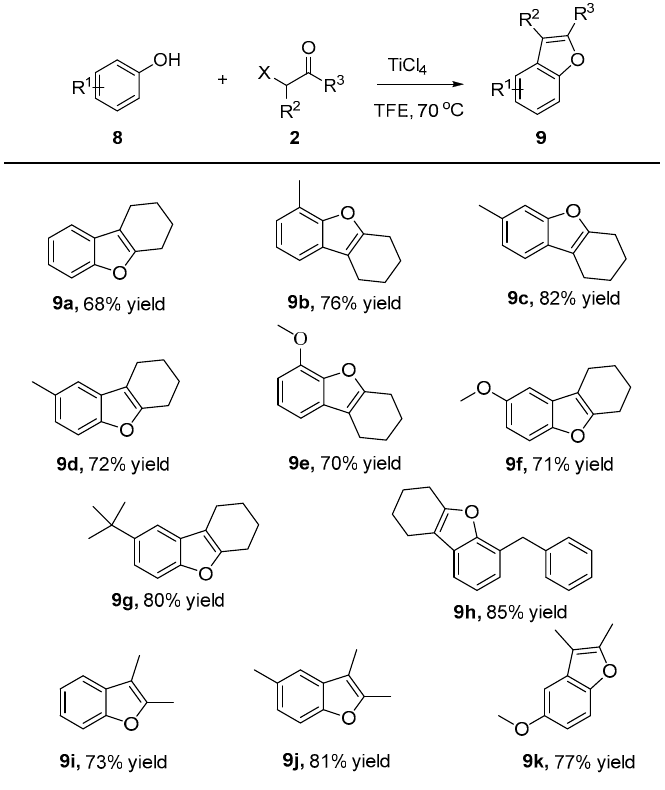
Table 4. Reaction of phenols with different α -haloketones a, b .